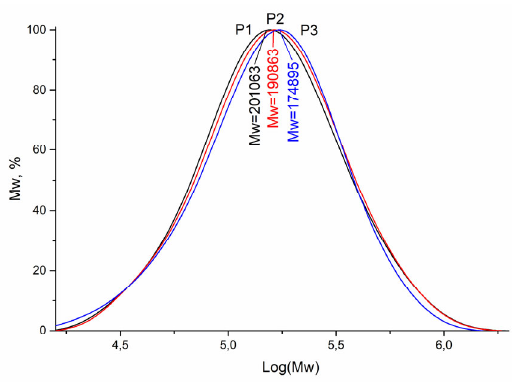
Figure 1. Molecular weight distribution of P1–P3 poly(VT- co -VK) copolymers (Table 1).